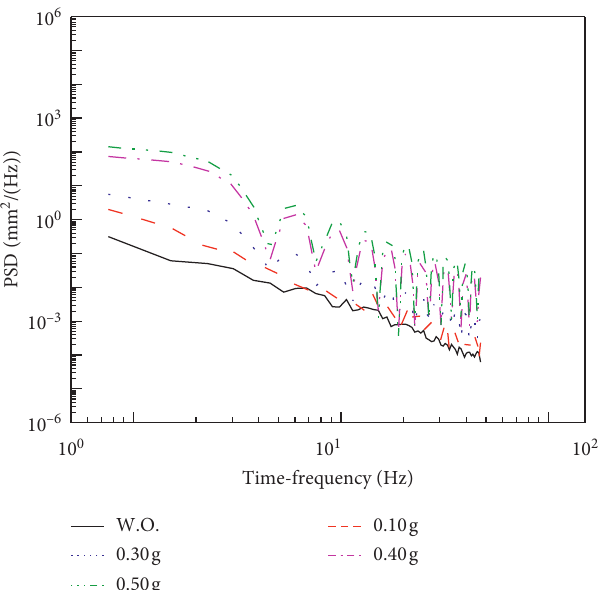
Figure 11: The comparison of alignment irregularity